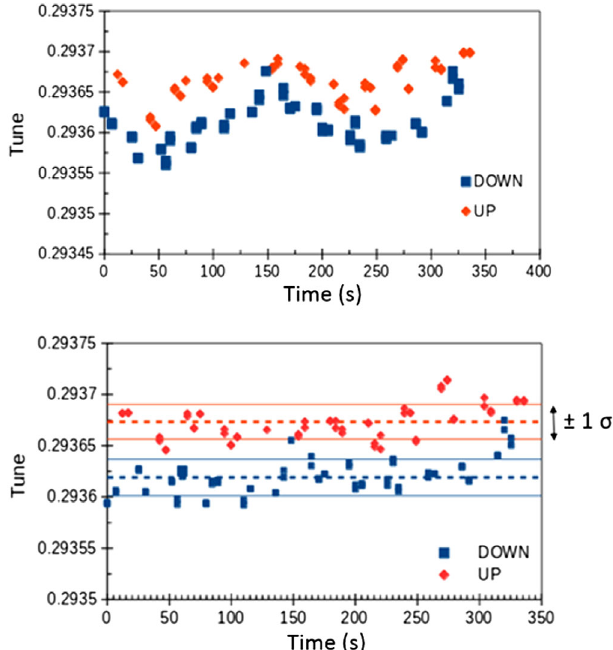
FIG. 15. By correcting for the tune jitter one can achieve tune resolution of ∼ 10 − 5 and clearly distinguish the tune shift created by low impedance coatings. Tune measurements for the colli- mator jaws open and closed: top — before, bottom — after the correction. TiN stripe, 4 . 5 σ halfgap. Solid lines represent 1 rms deviation from the mean (dashed